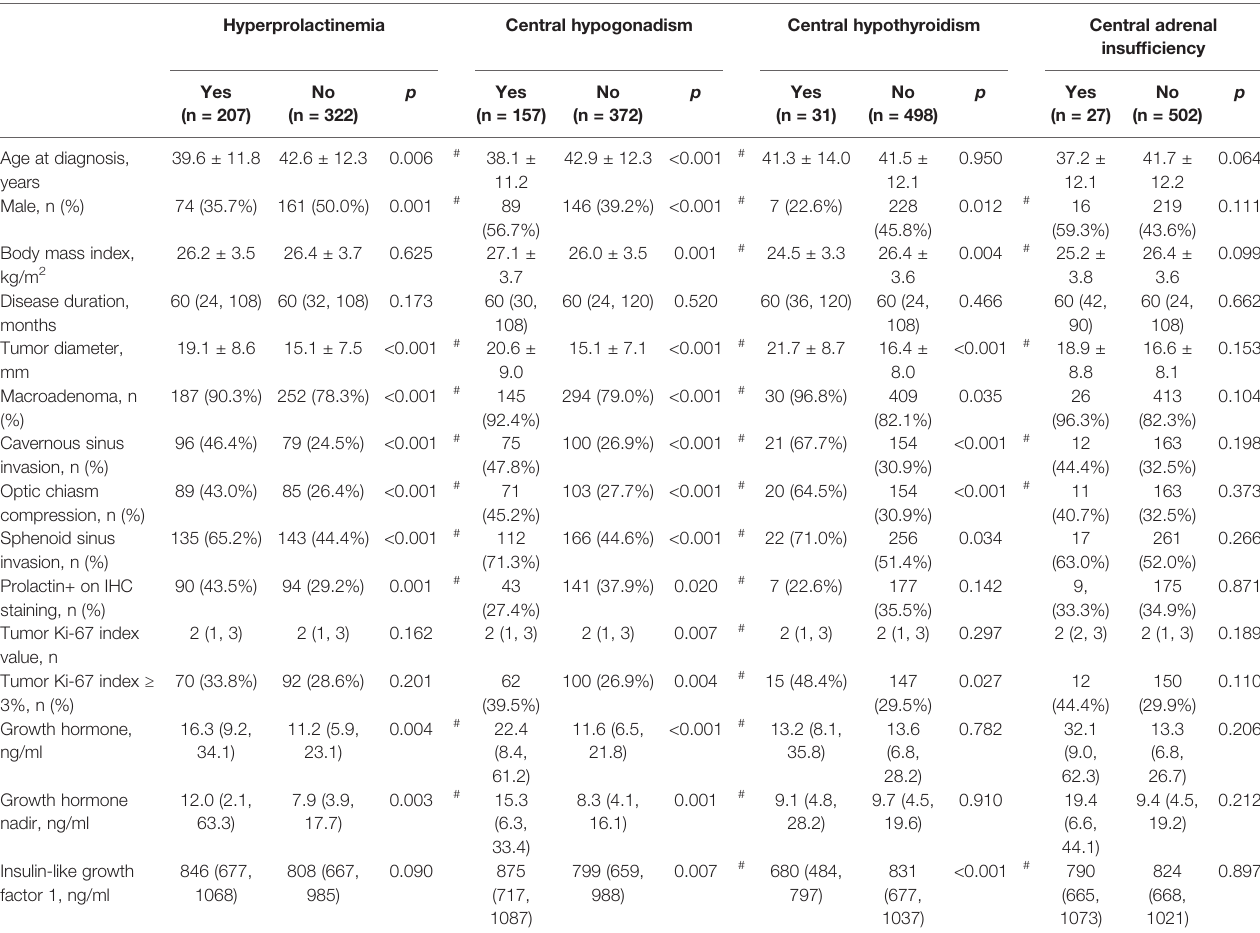
TABLE 2 | Clinicopathological correlations of hyperprolactinemia and hypopituitarism in acromegaly.